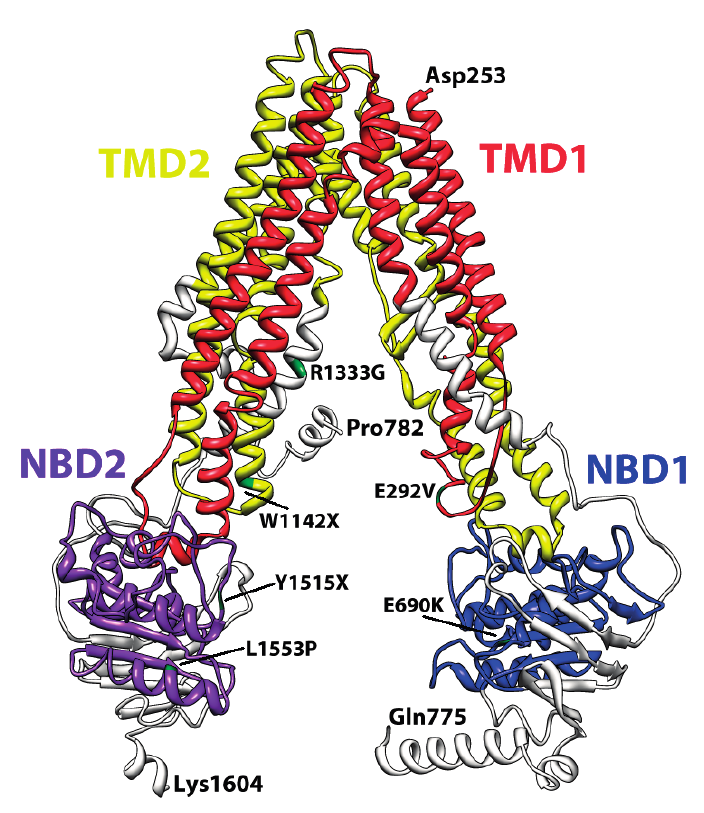
Figure 5. The color-coded 3D model of ABCA3 and the localization of some of the most frequent mutations reported in the literature